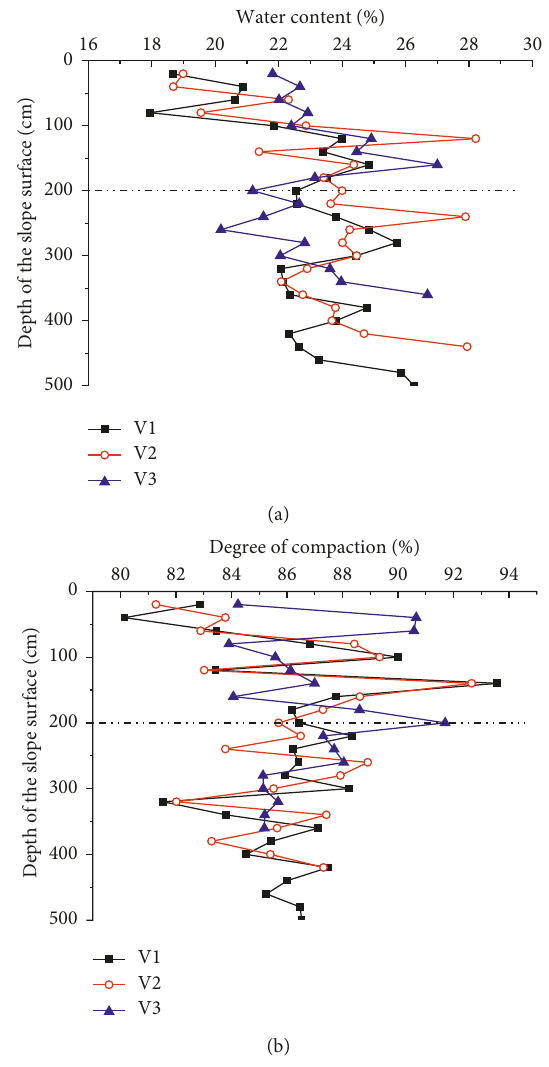
Figure 7: Water contents (a) and degrees of compaction (b) for the existing